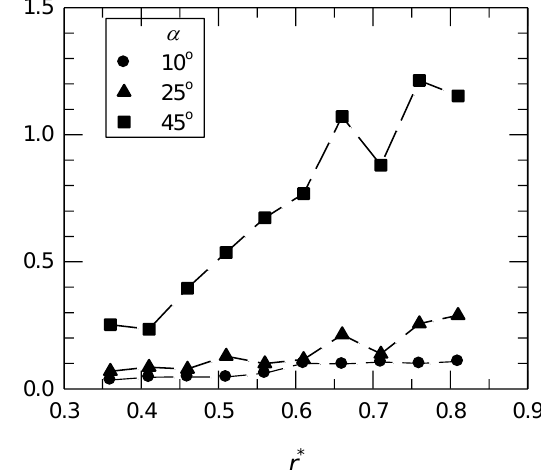
Figure 5. Vorticity contours around the base wing model without alula-VG on different x-z planes at α = 45°. ( a ) r * = 0.36, ( b ) r * = 0.46, ( c ) r * = 0.56, ( d ) r * = 0.66, ( e ) r * = 0.76, and ( f ) r * = 0.8.